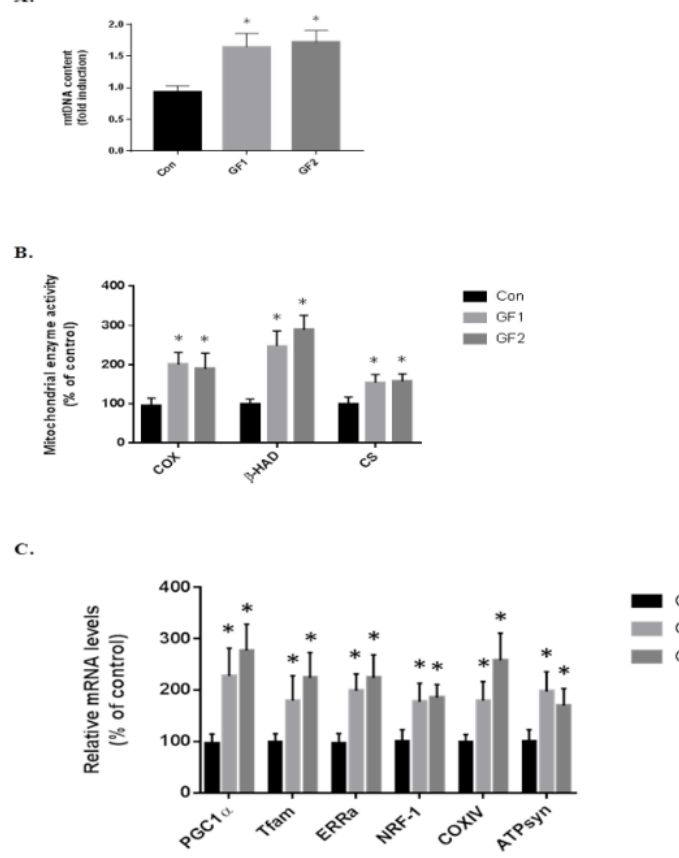
Figure 3. Effect of GF diets on muscle mitochondrial biogenesis in C57BL/6 mice. ( A ) The amount of mitochondrial DNA (mtDNA) in mice that were fed a control diet or a diet enriched in GF as determined by the mtDNA/genomic DNA ratio. ( B ) The activity of mitochondrial enzymes COX, β -HAD and CS were evaluated as a percent of control. ( C ) The relative mRNA levels of PGC-1 α , Tfam, ERR α , NRF-1, COXIV and ATPsyn in controls and GF fed mice. The results are expressed as the mean ± SD ( n = 10 per group), * p < 0.01 compared to the control group.